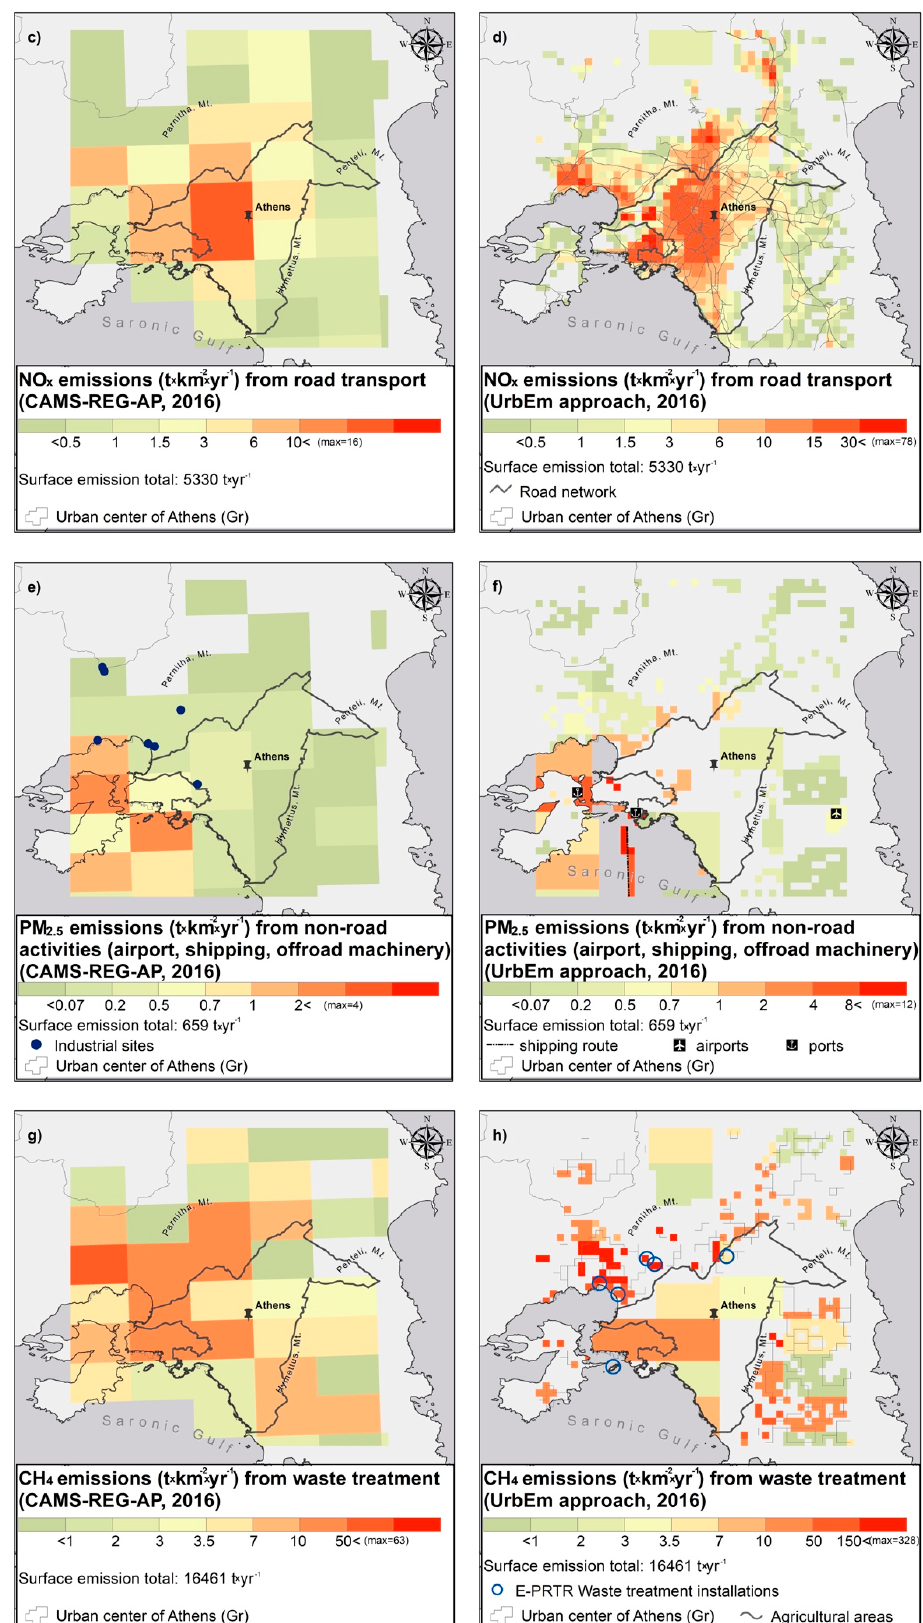
Figure 7. As in Figure 6, but for